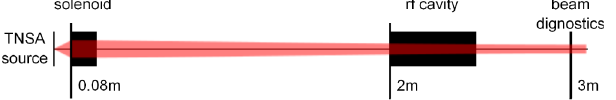
FIG. 1. The 15 cm long pulsed solenoid is positioned 8 cm behind the laser target and is typically set to focus 9.6 MeV protons at 3 m (maximum field at the solenoid of 7.5 T). The cavity (550 mm long) starts at 2 m and is followed by a diagnostic box around 3 m, where RCF stacks, a diamond ToF detector and a magnetic dipole detector can be placed (details in text).